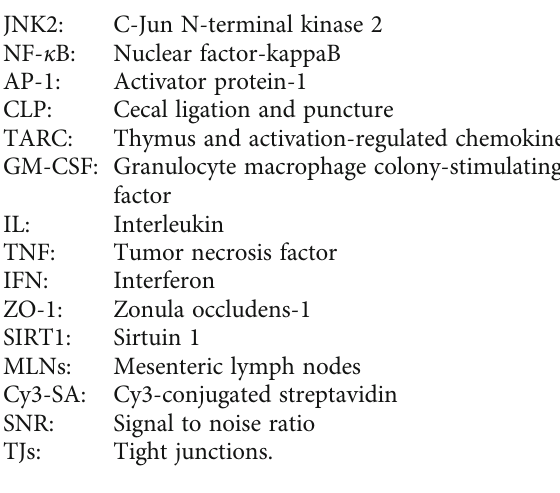
Table S1. Cytokines microarray with 40 factors. Table S2. Phosphorylation microarray with 17 proteins. Figure S1. ences between mean values were assessed by one-way ferences compared with CLP group. Figure S2. Inhibitory e ff ect of emodin on the oxidative stress in septic mice. Data represents the mean ± SD of three independent experiments, and di ff erences between mean values were assessed by one- compared with control group. Figure S3. The SPR detection of JNK2 and Emodin combination. Figure S4. Root mean square deviation (RMSD) of the simulation. The abscissa represents the time and the ordinate represents the speci fi c value of RMSD. Figure S5. Quanti fi cation of WB in Figure 5(c). (Supplementary